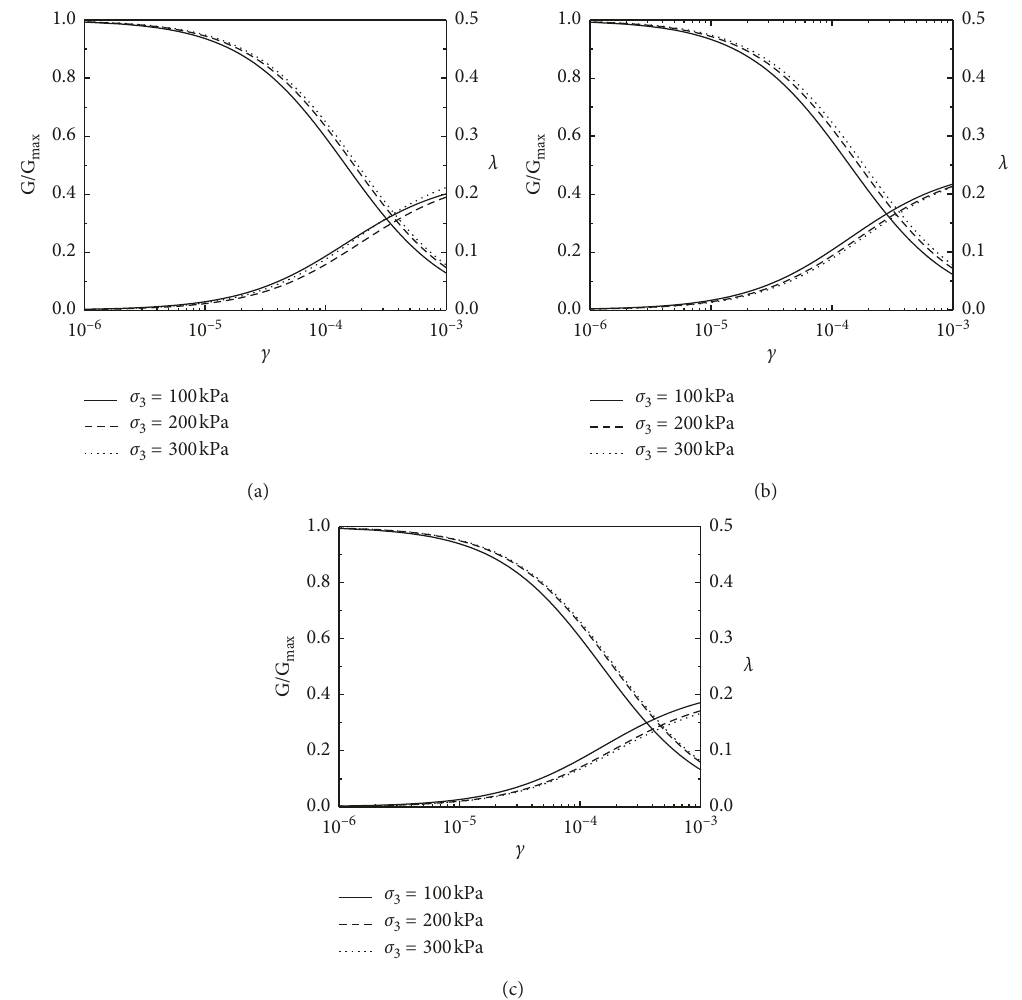
Figure 10: Fitted curves of G / G